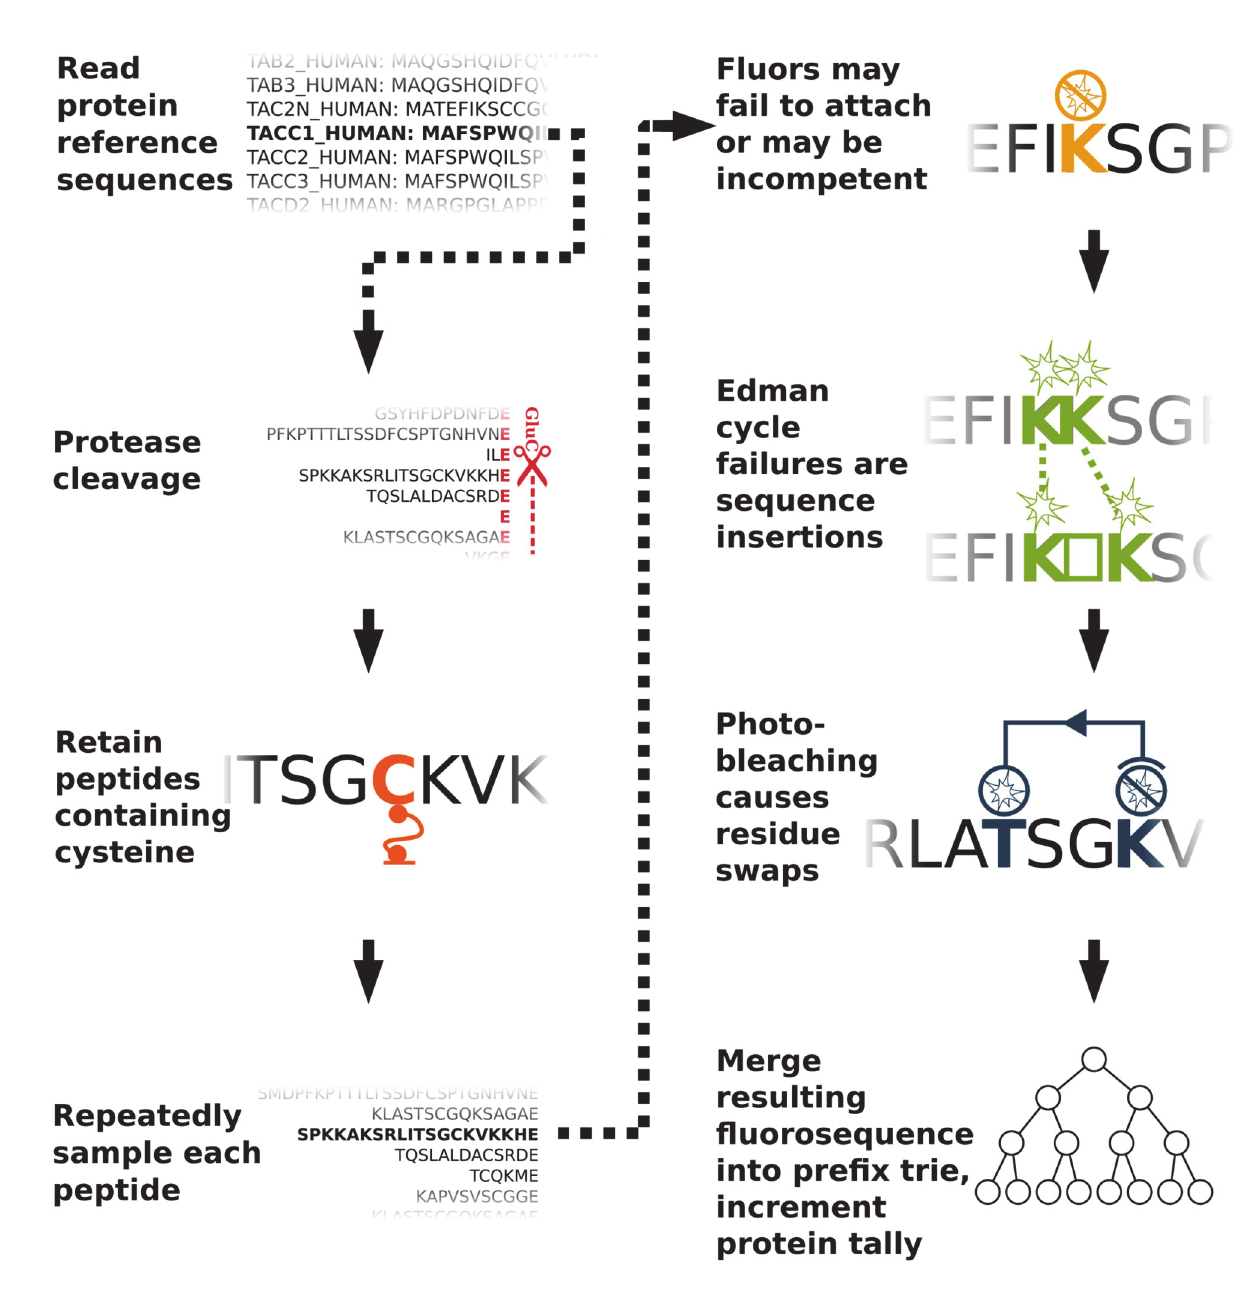
Fig 4. Overview of a Monte Carlo simulation of fluorosequencing with errors. In detail, protein sequences are read as amino-acid character strings from the UniProt database. For each protein sequence, the subsequent steps are repeated: proteolysis was simulated and peptides lacking the residue for surface attachment (e.g. cysteine) were discarded. All remaining peptides were encoded as fluorosequences and subsequent steps were repeated in accordance to the desired sampling depth: The fluorosequences were altered via random functions modeling experimental errors — (1) labels were removed modeling failed fluorophores or failed fluorophore attachment, (2) positions of the remaining labels were randomly dilated modeling Edman reaction failures, and (3) fluorophores were shifted upstream from their positions, modeling photobleaching. Each resulting fluorosequence was sorted based on its position and label type and merged into a prefix trie to tally the frequencies of observing each fluorosequence from a given source protein.